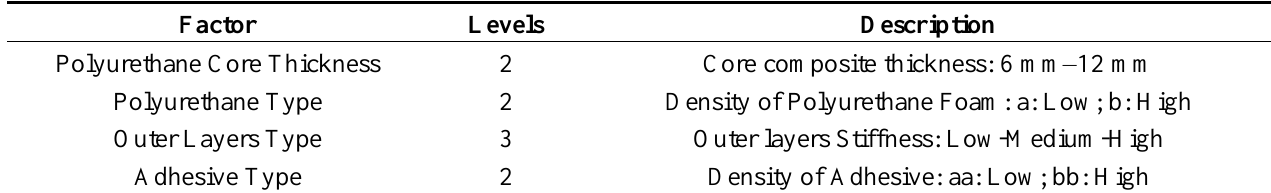
Table 3. Factors of computational parametric